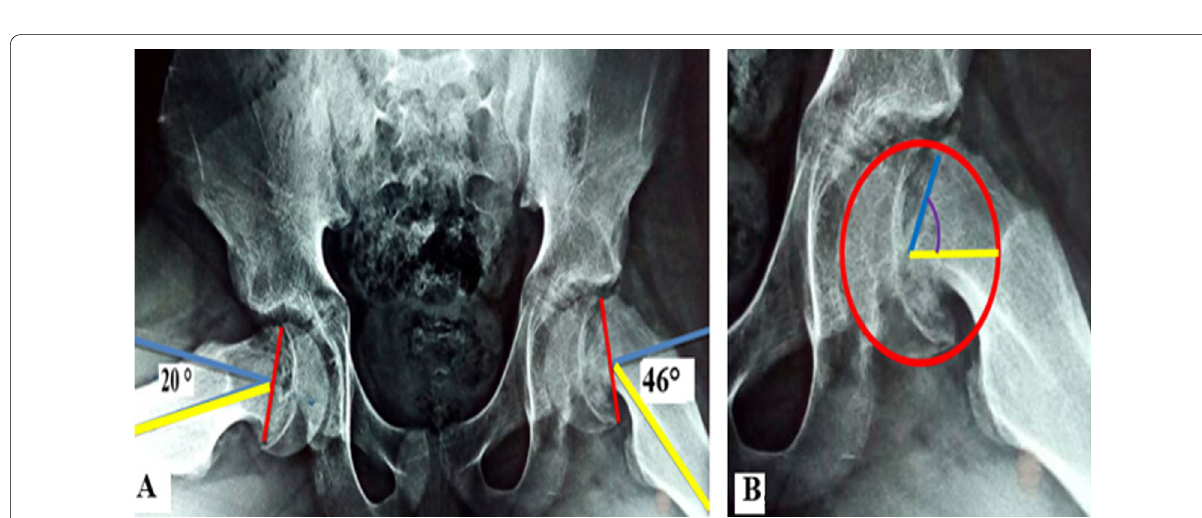
Fig. 2 A Measurement of the epiphyseal‑shaft angle bilaterally. B Measurement of the alpha